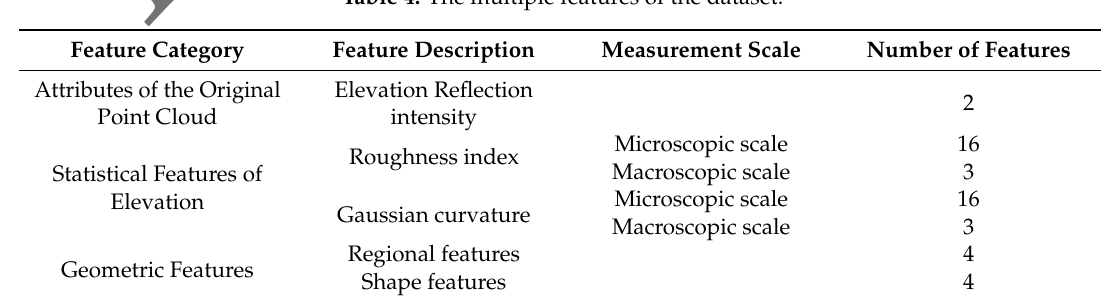
Table 4. The multiple features of the